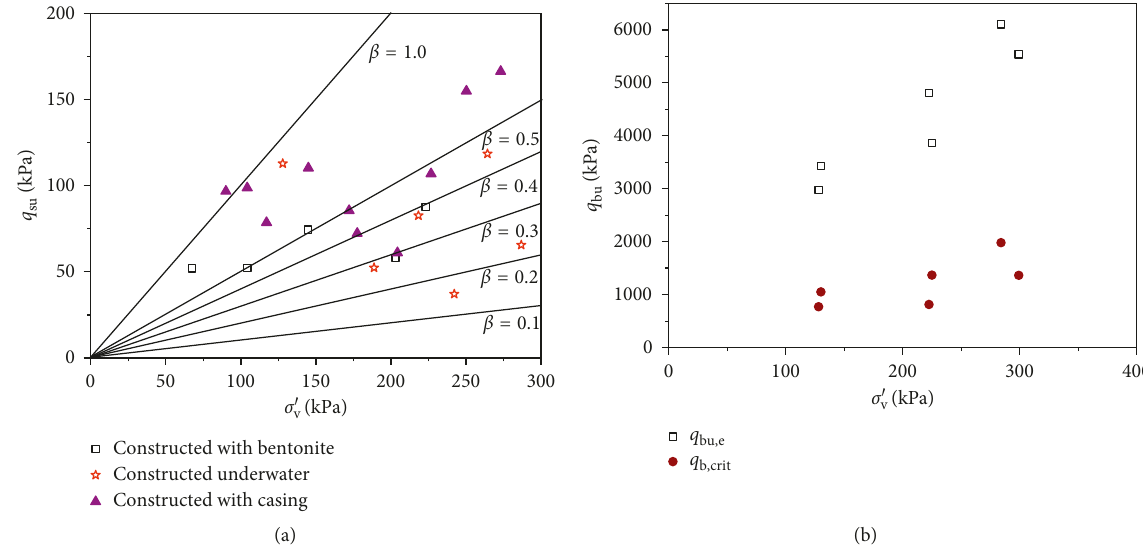
Figure 11: Relationship of the average effective vertical stress ( σ resistance ( q ) bu in granite residual soil. (a) ( q ) su versus σ v